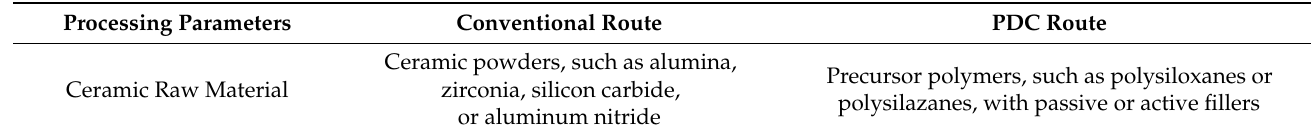
Table 1. Main processing parameters for manufacturing ceramics via conventional route and PDC route